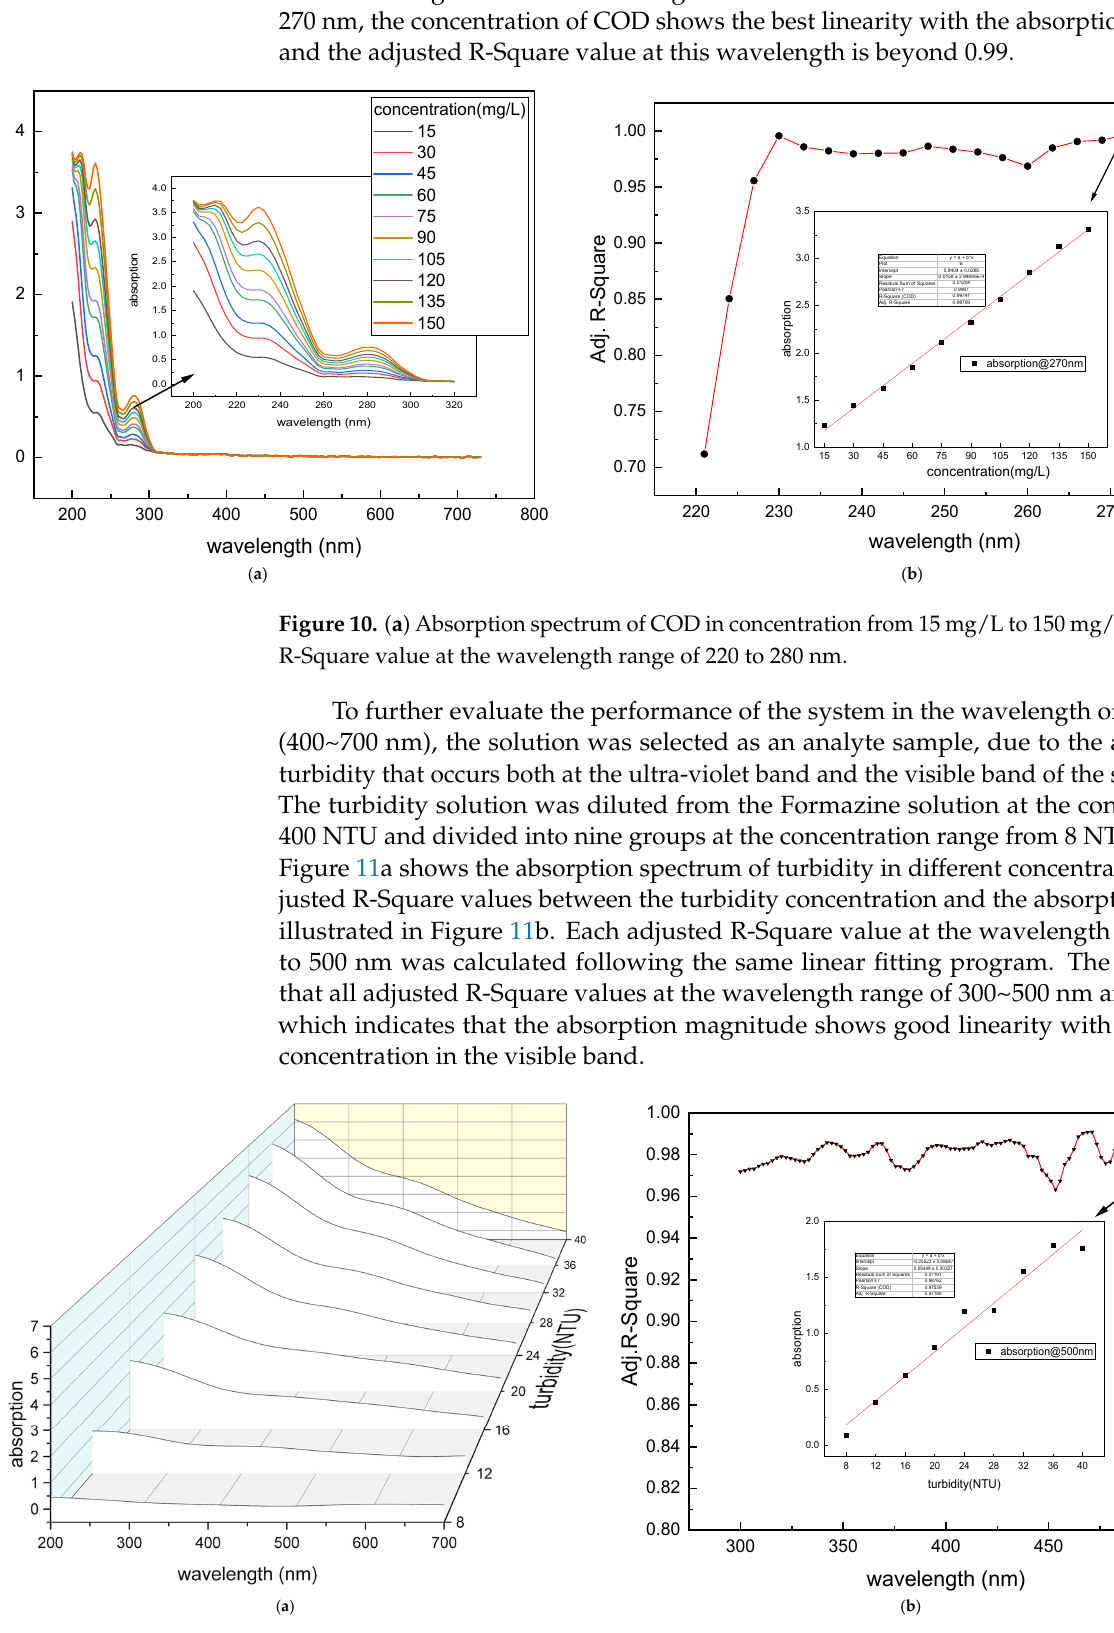
Figure 11. ( a ) Absorption spectrum of turbidity in different concentrations. ( b ) Adjusted R-Square value at the wavelength range of 300 to 500 nm.